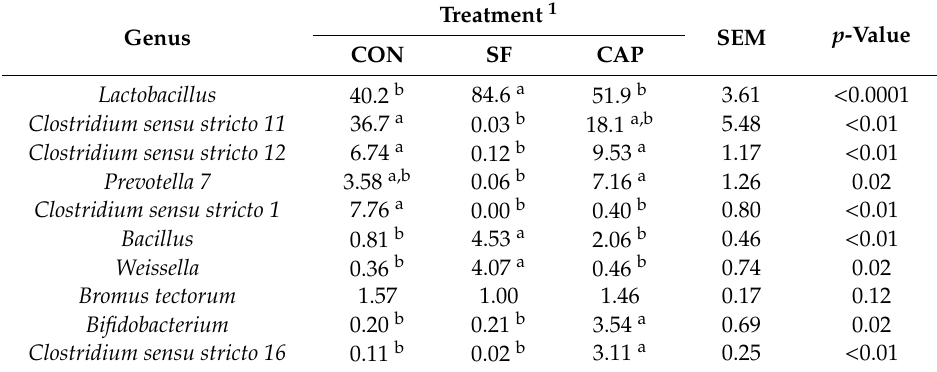
SF = sodium formate (3 g / kg FW); CAP = calcium propionate (3 g / kg